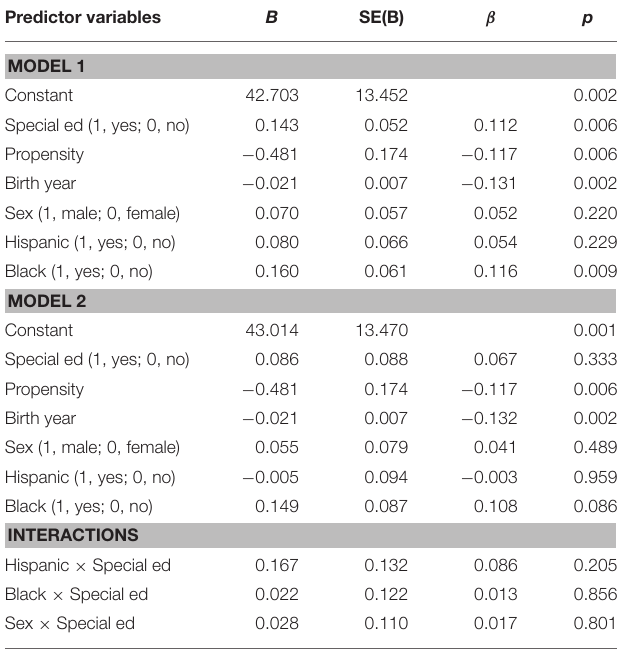
TABLE 6 | Hierarchical multiple logistic regression analyses predicting welfare use ( n = 586). Predictor variables